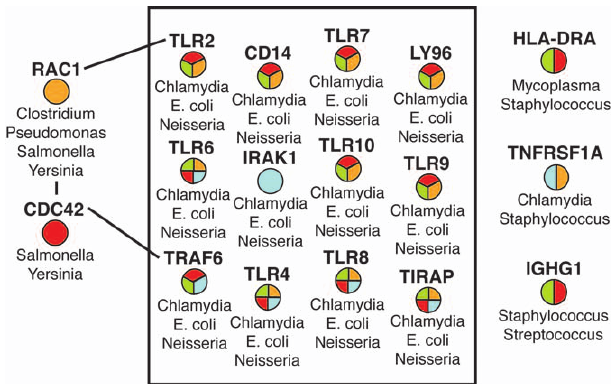
Figure 6. Human Immune System Proteins Interacting with Multiple Bacterial Pathogen Groups Enriched network of human proteins annotated with ‘‘ immune system process ’’ (red), ‘‘ response to wounding ’’ (orange), ‘‘ immune response ’’ (green), and ‘‘ I- j B kinase/NF- j B cascade ’’ (blue). The proteins in the black box form a dense network of PPIs; we have left these out for clarity. An edge connecting two proteins denotes a known interaction in the human PPI